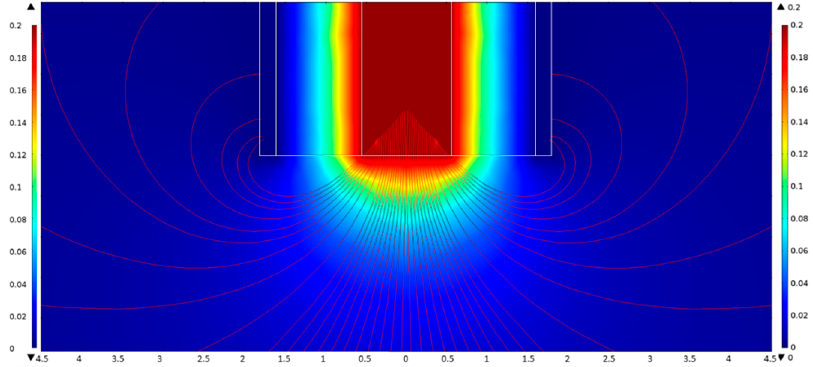
Figure 4. The electric field pattern of the fringing field surrounding open-ended coaxial electrodes with 3.6 mm φ for the outer conductor. The color indicates the spatial distribution of potential between zero and 200 mV.